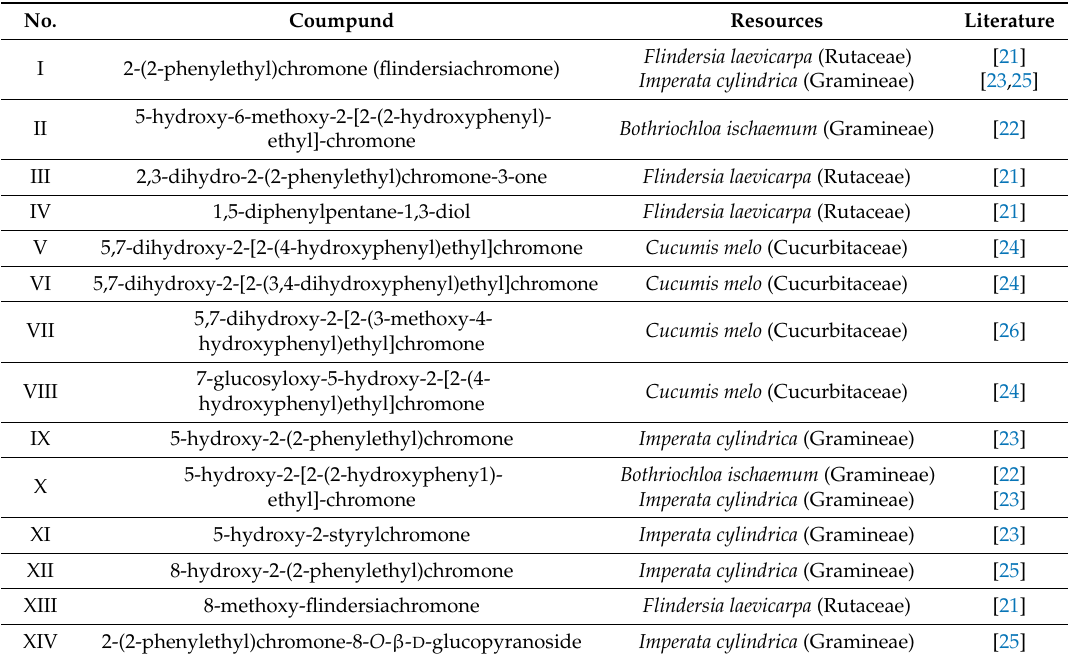
Table 4. Summarizing PECs of nonagarwood